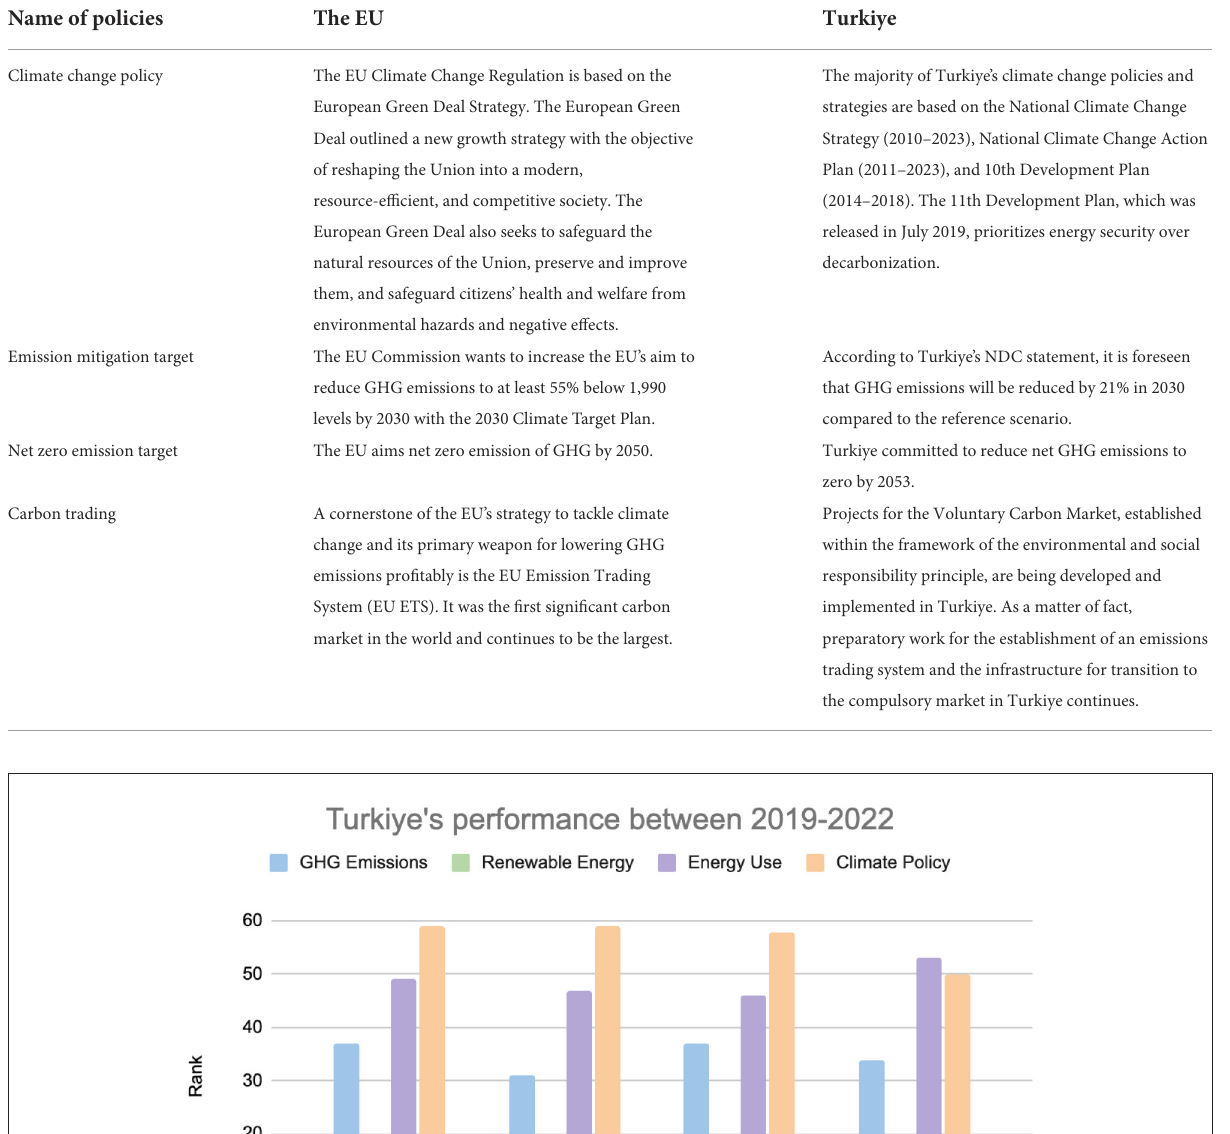
production continues to increase with regulations such as the Renewable Energy Law and the National Energy Policy (Akdogan and Kovancilar, 2022). Since 2019, renewable energy has provided ∼ 48% of total electricity production in Turkiye. The majority of this is made up of hydraulic energy.